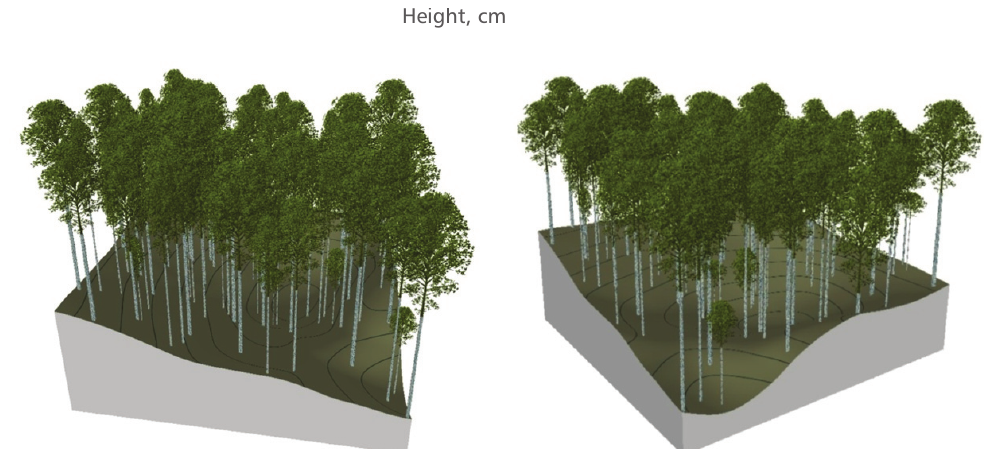
FIGURE 7. Visualization of beech stand on the experimental plot (En Vision), two